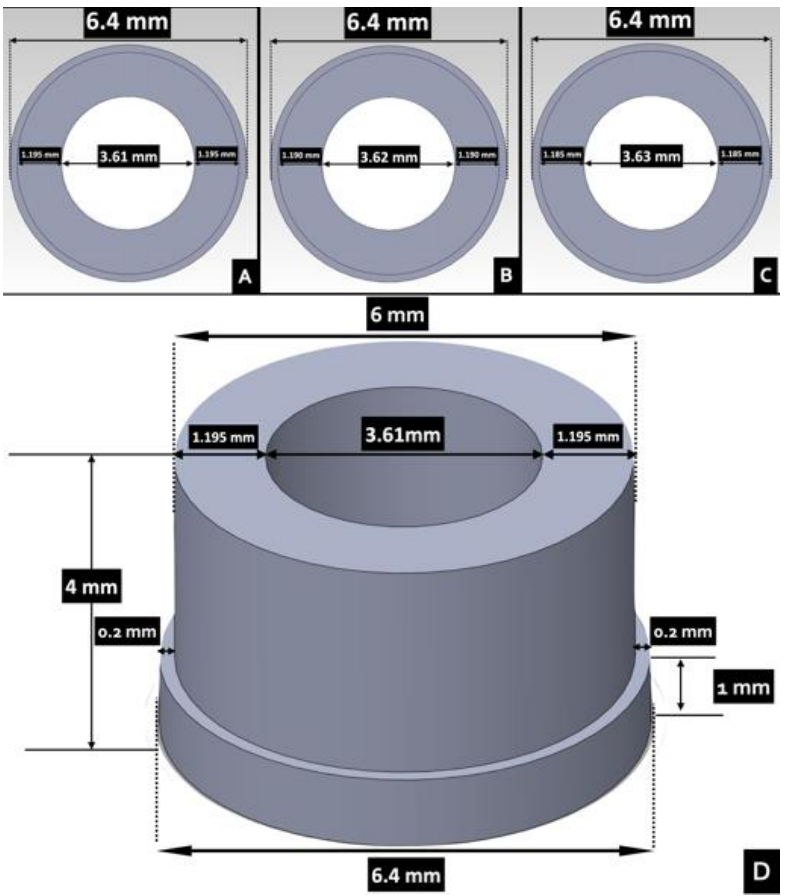
Figure 1. Simulated clinical position and the guided stents on epoxy tooling board model.